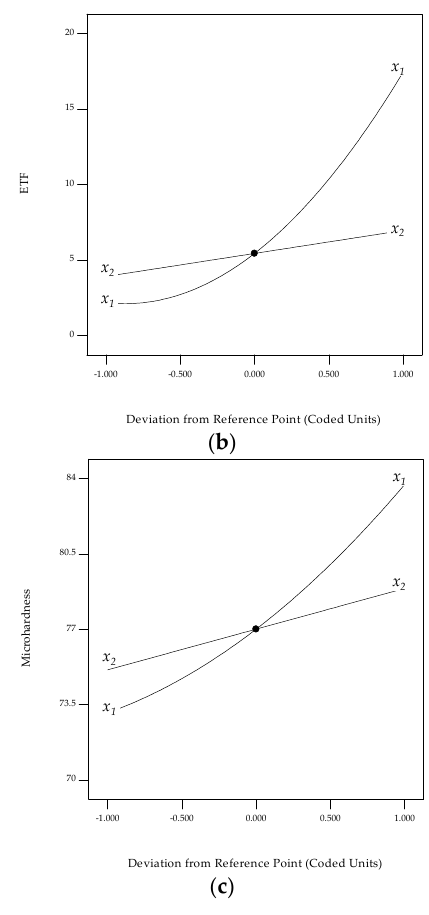
Figure 5. Perturbation plot of the factors for ( a ) UTS, ( b ) ETF, and ( c ) MH.